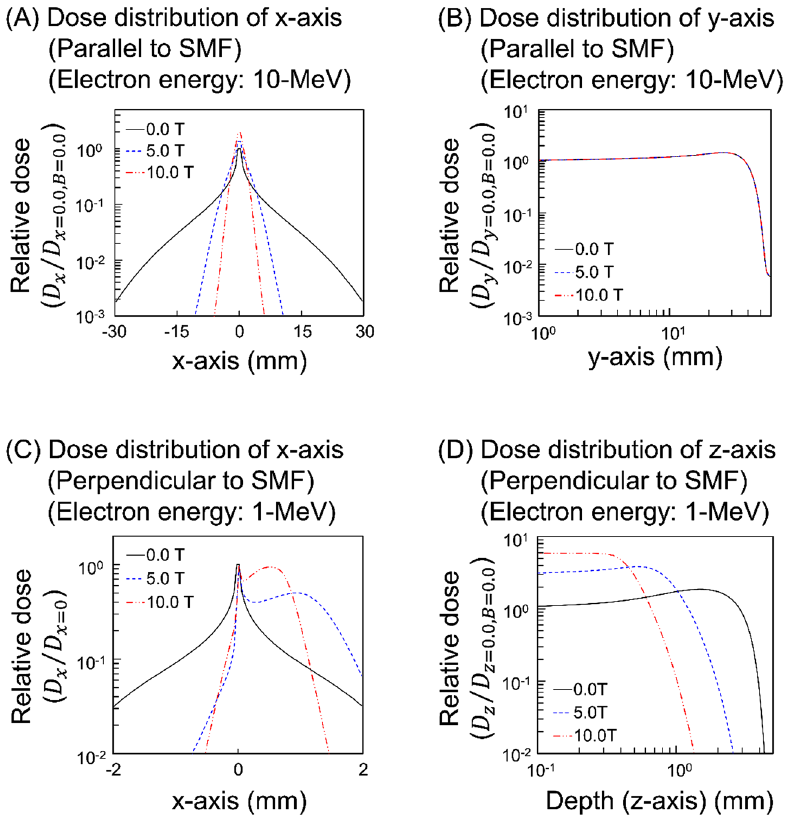
Figure 1. Dose distribution of electrons in SMFs. Dose distributions along the x-axis ( A ) and y-axis ( B ) for 10-MeV incident electrons in the positive y-axis direction parallel to the SMF calculated by EGS. The distributions along the x-axis ( C ) and z-axis ( D ) for 1-MeV incident electrons in the positive z-axis direction perpendicular to the SMF calculated by EGS. We confirmed that the distributions calculated by etsmode were in good agreement with those by EGS as shown in supplementary data (Fig. S2). The distributions for 10-MeV and 1-MeV electrons were significantly affected by the